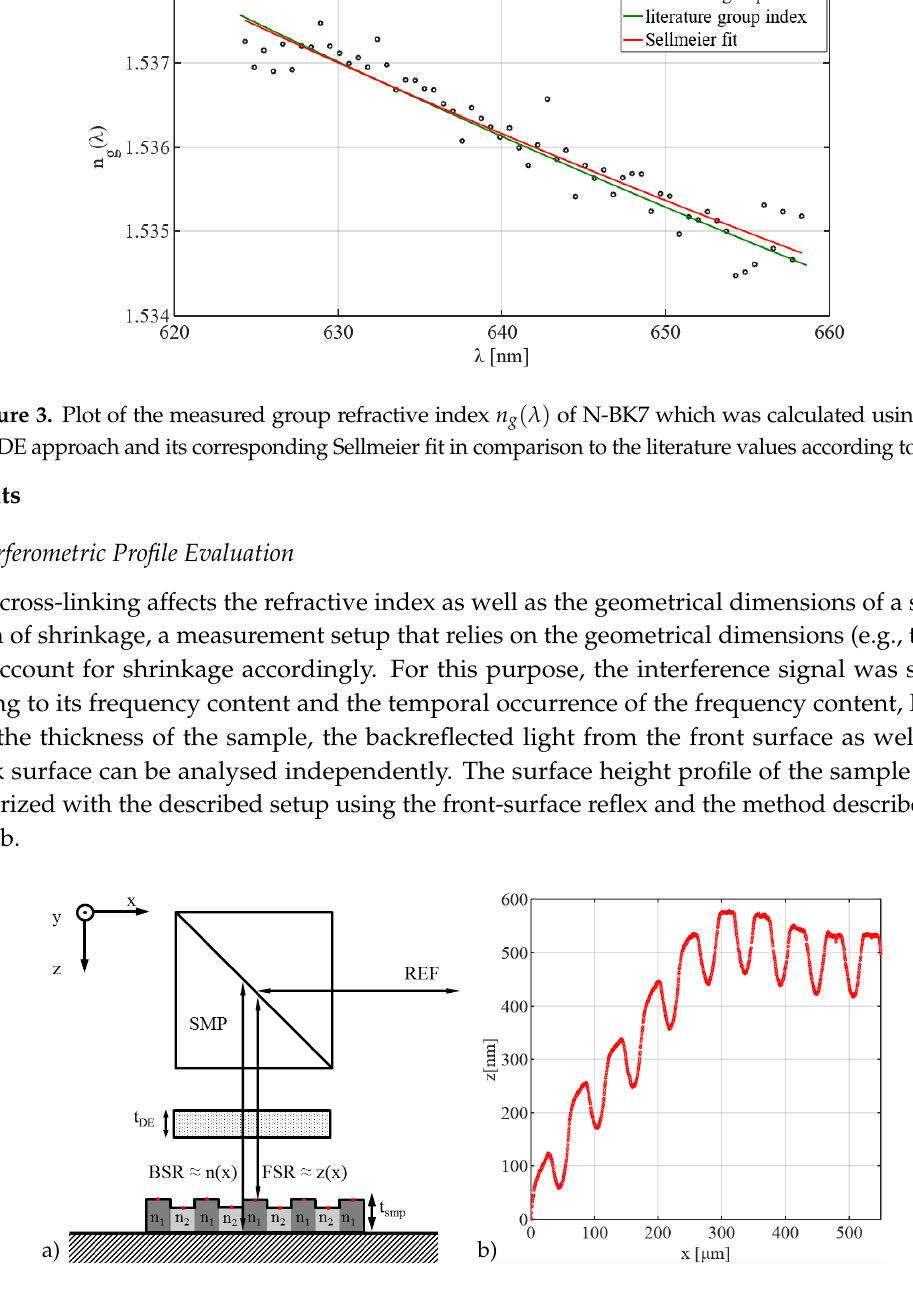
Figure 4. ( a ) Experimental schematic on a lithographically structured sample of the thickness t smp with varying refractive indices, n 1 and n 2 , along the x -axis in the SMP—sample arm where the FSR-front surface reflex contains information on the surface height profile z ( x ) due to shrinkage and the BSR-back surface reflex contains information on the refractive index slope along the x -axis n ( x ) in a setup with a dispersive element of the thickness t DE . Probe points for single RDOT measurements are marked with red dots on the sample while REF indicates the reference arm; ( b ) Plot of the measured surface profile z ( x ) from a polymer sample under investigation utilizing a wavelength-calibrated imaging